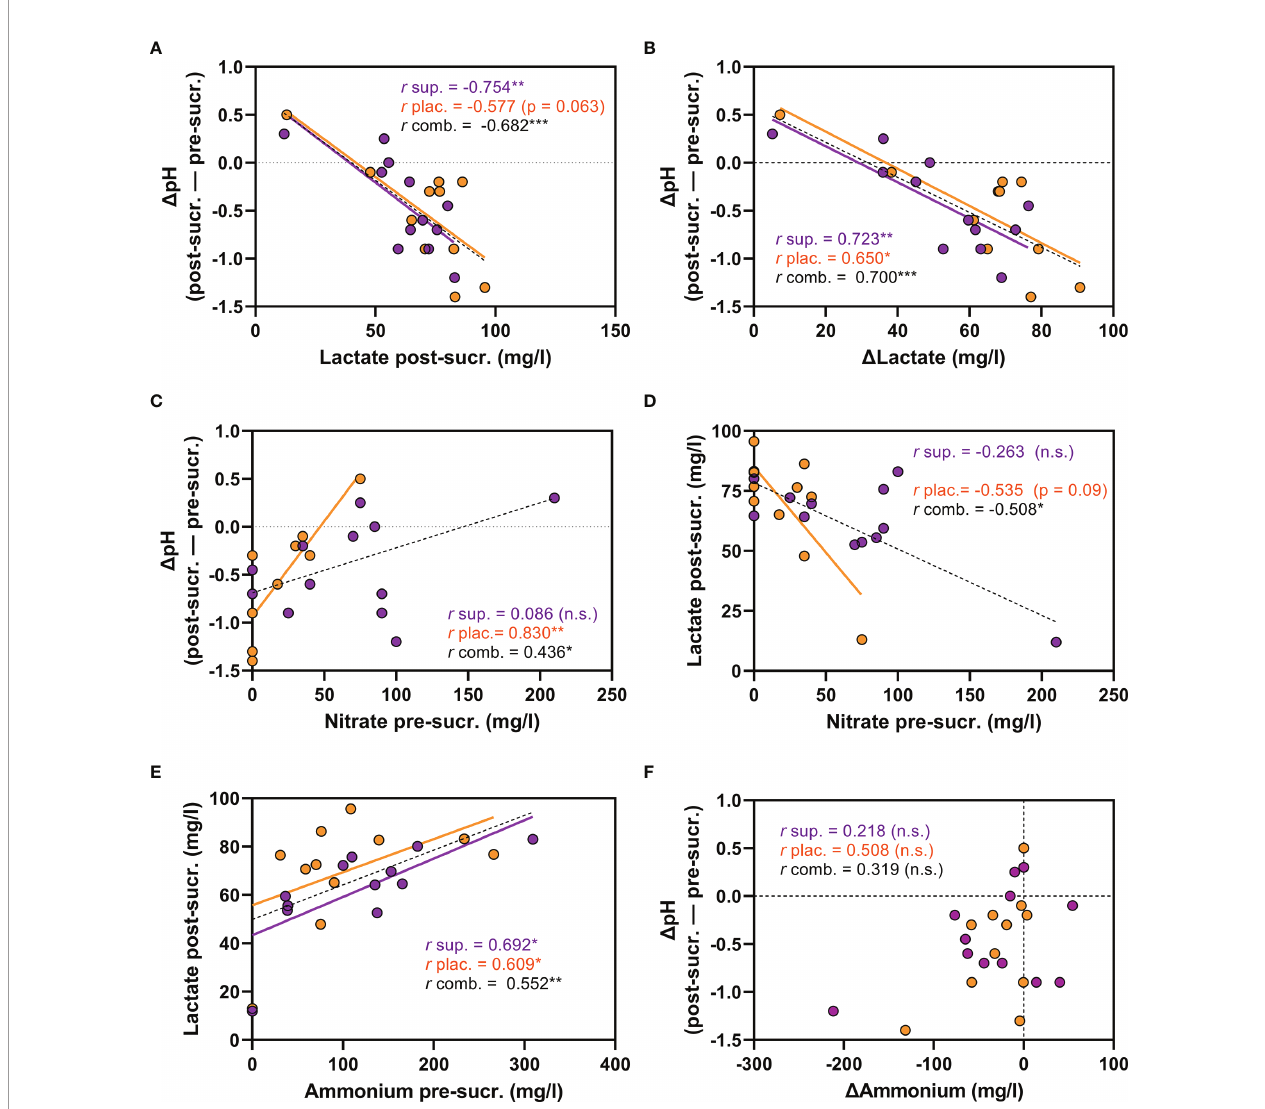
FIGURE 3 | Correlations between physiological parameters 2 h after nitrate-rich supplement and placebo intake. In (A – F) , correlations between different physiological parameters are shown. The purple dots are measurements 2 h after nitrate-rich supplement intake (n = 12) and the orange dots 2 h after placebo intake on a different day (n = 12). The black dotted lines are the linear regression curves when combining the measurements after supplement and placebo intake (total n = 24). The D pH is the pH difference between the pre-sucrose measurement and the post-sucrose measurement (negative values are a pH drop). (A) D pH and lactate detected post-sucrose. (B) D pH and D lactate. (C) D pH and salivary nitrate (pre-sucrose) (D) lactate detected post-sucrose and salivary nitrate (pre- sucrose). (E) salivary ammonium (pre-sucrose) and lactate detected post-sucrose. (F) D pH and D ammonium. sup., supplement; plac., placebo; comb., combined; pre-sucr., pre-sucrose measurements; post-sucr., 10 min post-sucrose measurement. Spearman-Rho correlations ( r ) were calculated 2 h after supplement (sup.) or placebo (plac.) intake, or both combined (comb.). P-values and linear regression curves are shown if trends were found (p 0.05-0.1). *p < 0.05, **p <0.01, ***p <0.001, n.s, not signi fi cant. D = post-measurement –